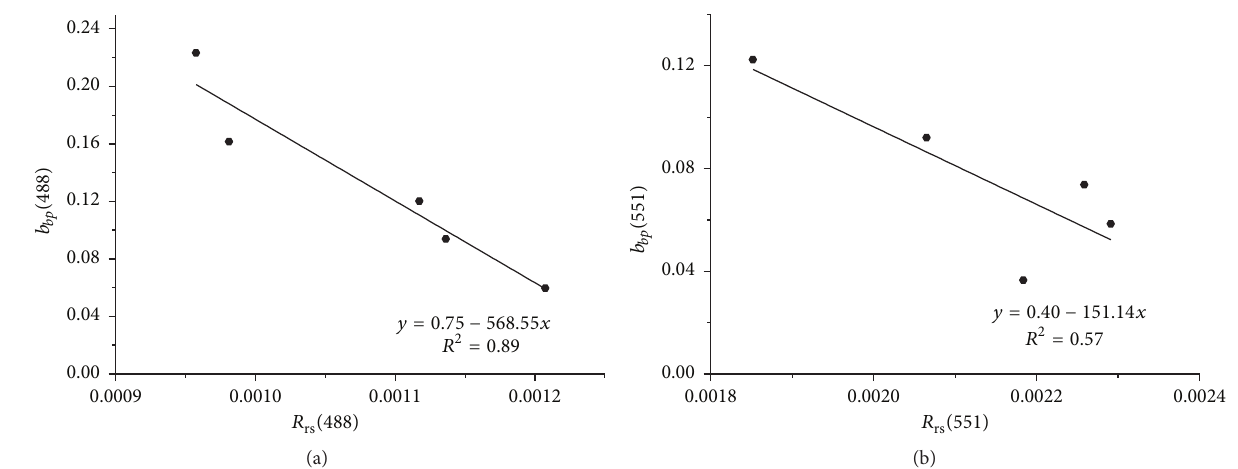
Figure 5: The backscattering coefficient versus remote sensing reflectance. (a) At 488 nm. (b) At 551nm.